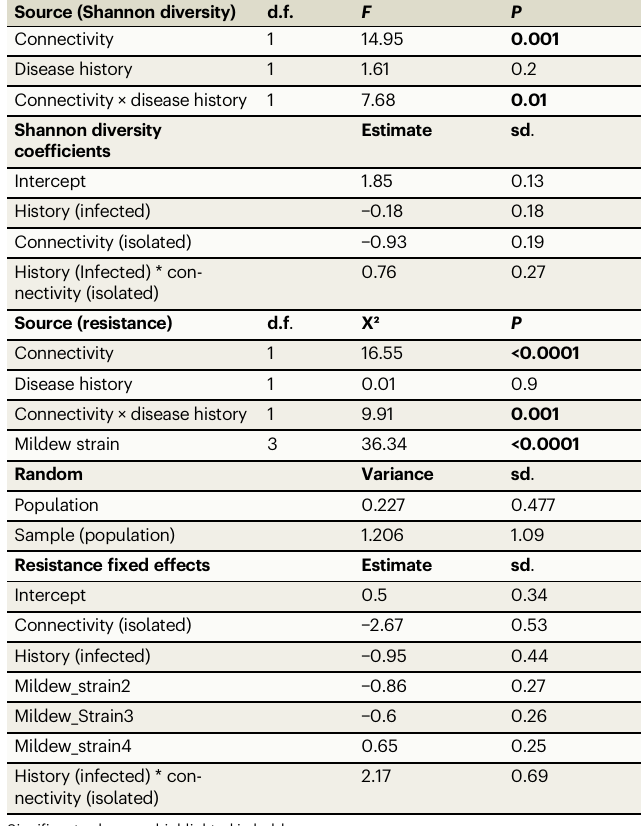
Table 1 | The effects and effect sizes of connectivity and dis- ease history on resistance diversity (Shannon diversity), and the average level of resistance in the 19 studied Plantago lanceolata